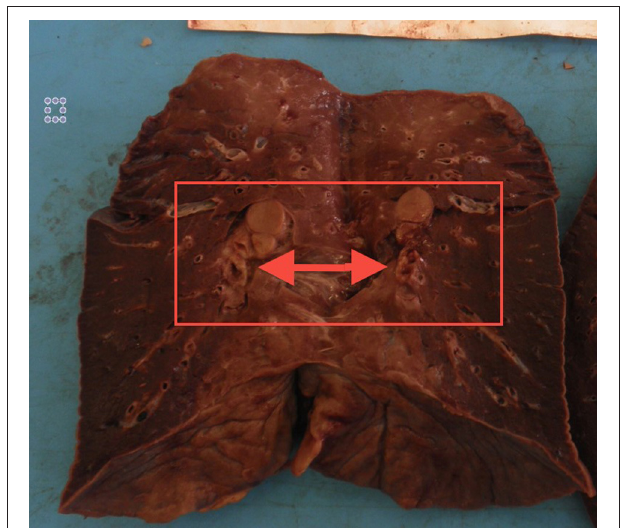
FIGURE 1 | Pulmonary hilum in formaldehyde fixed lung, after vertical section. Gross examination allowed to identify a compression of the vessels and bronchi due to expansive lymph-like masses in the hilum. Similar evidence was found in the other